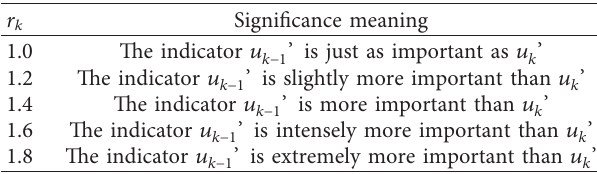
Table 4: Criteria for judging the importance of indicators. r k Significance meaning 1.0 The indicator u k −